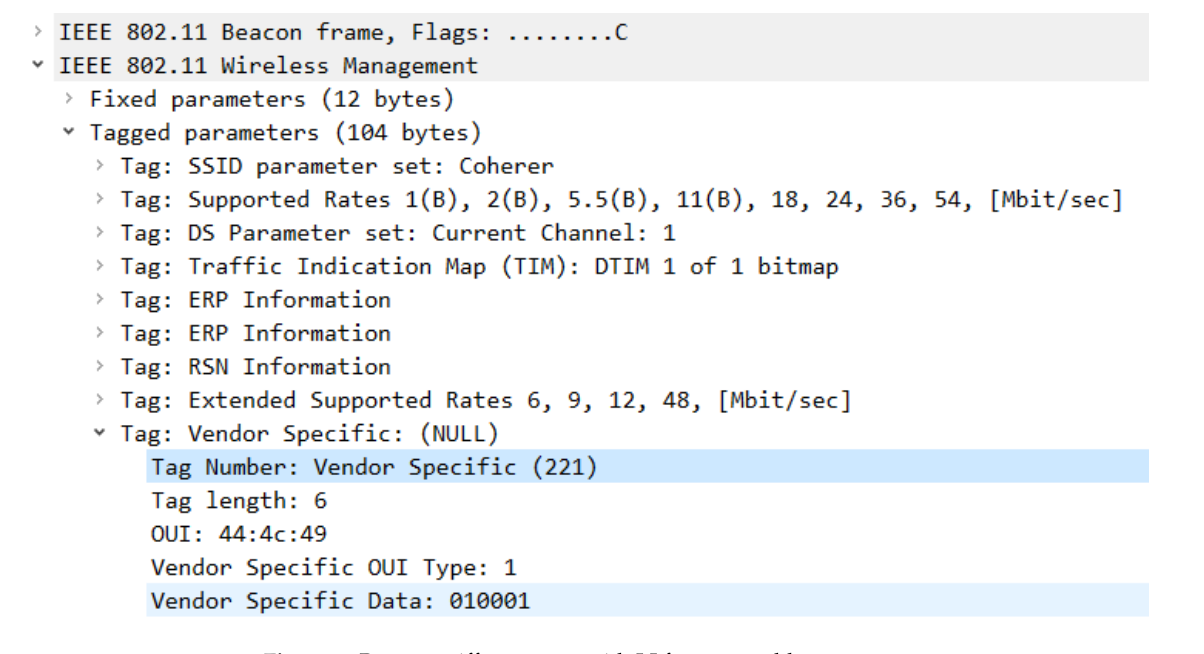
Figure 9. Beacon sniffer capture with LI feature-enable.